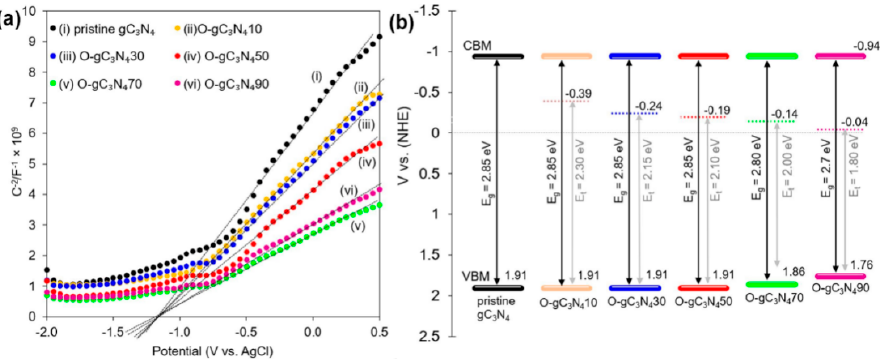
Figure 1. Mott–Schottky plots for as-synthesized g-C 3 N 4 and O-g-C 3 N 4 samples ( a ) and postulated band structure of pristine g-C 3 N 4 and increasing oxidation of g-C 3 N 4 ( b ) Reprinted from [24], Copyright (2020), with permission from Elsevier.